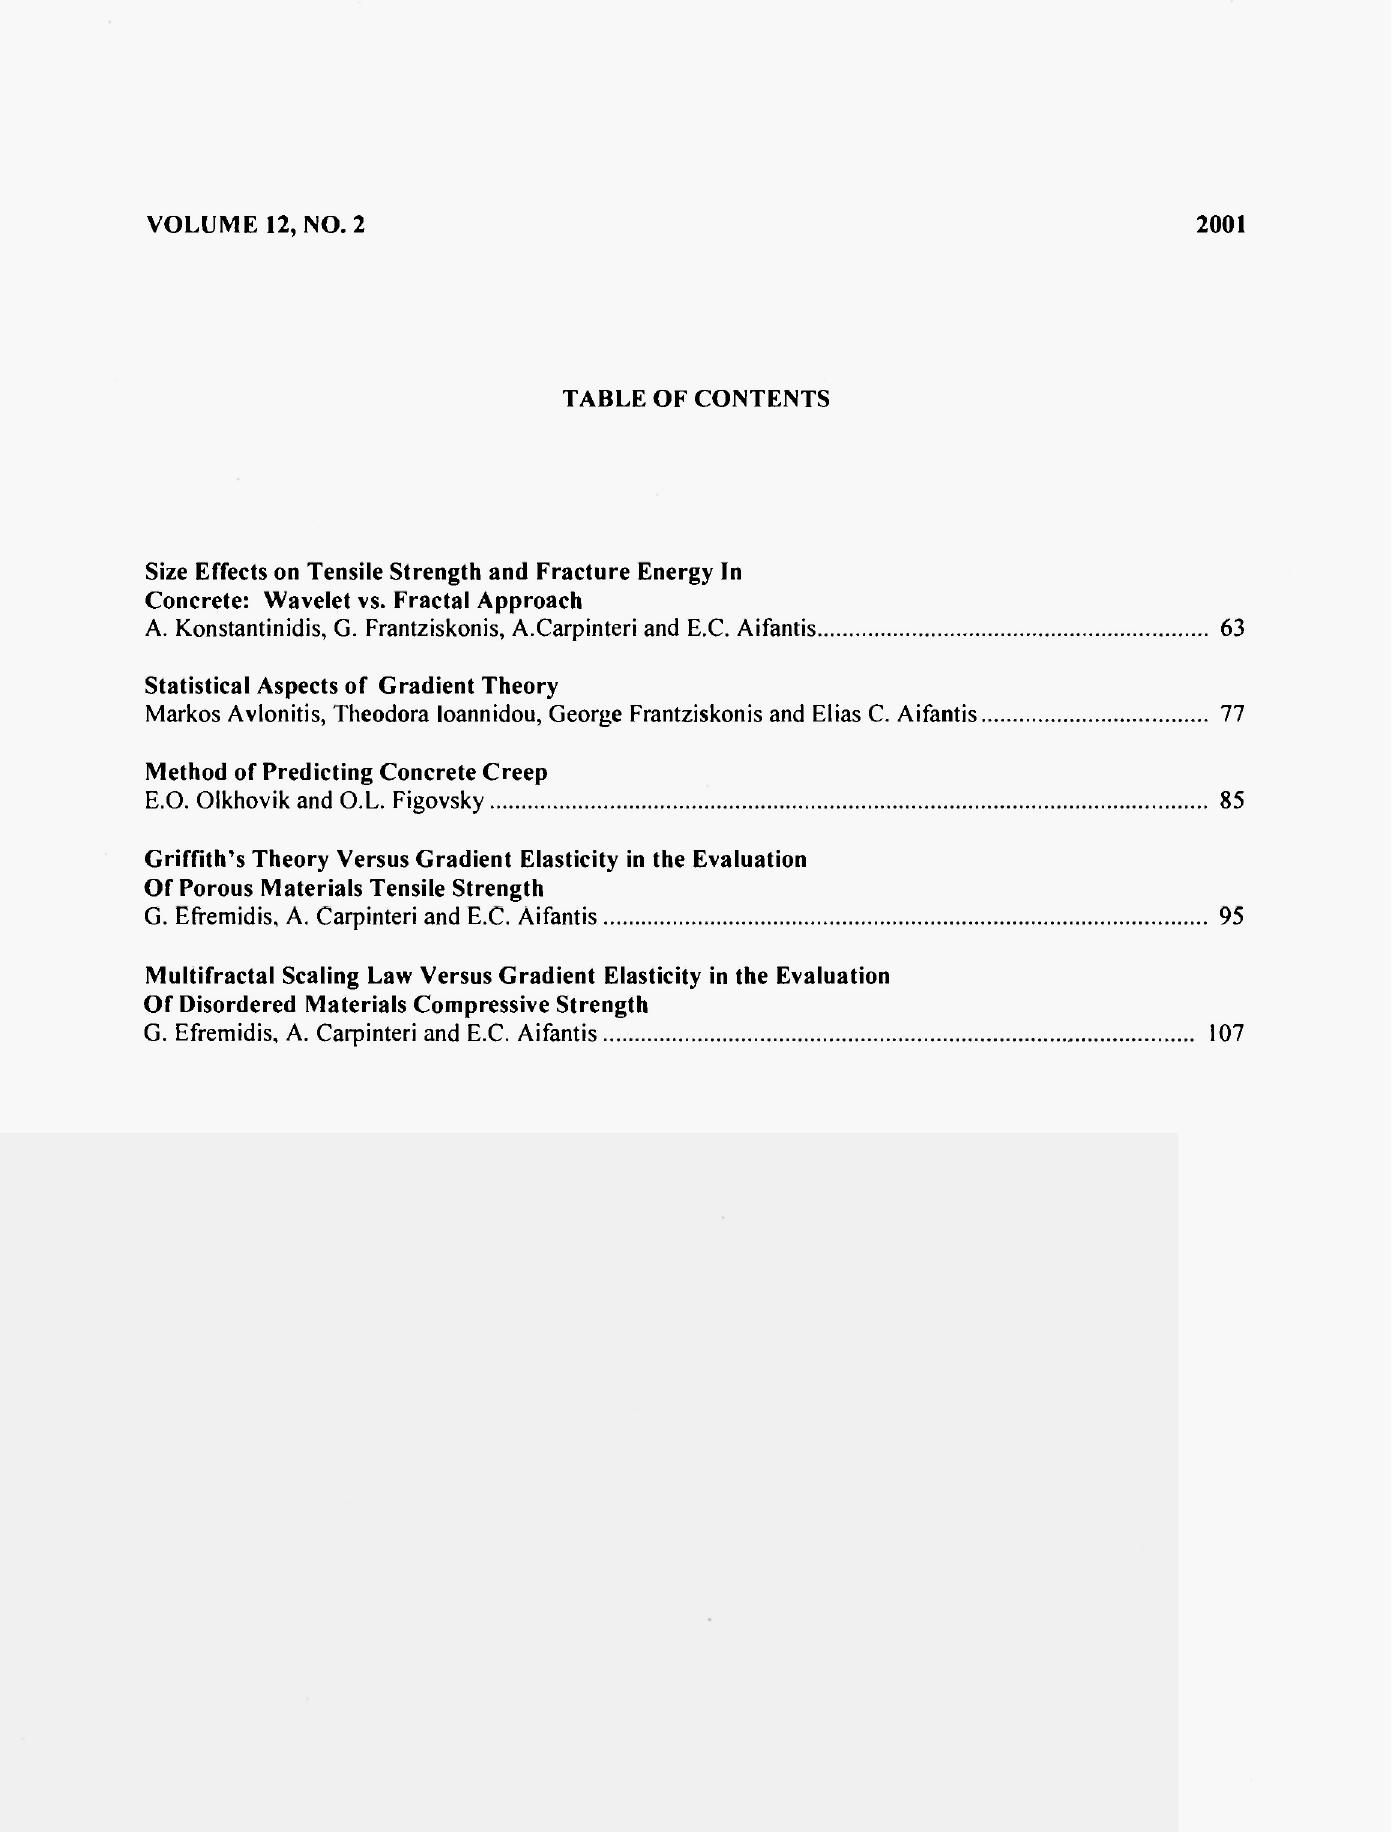
Size Effects on Tensile Strength and Fracture Energy In Concrete: Wavelet vs. Fractal